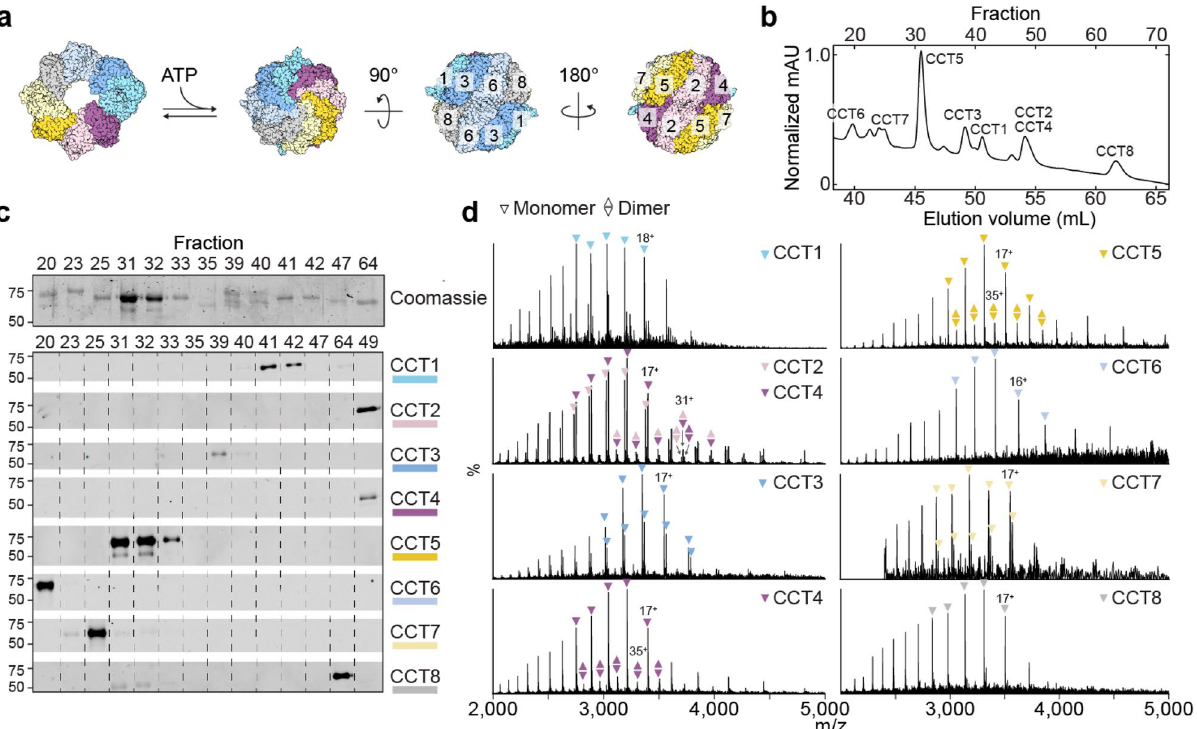
Figure 1. hTRiC subunits can be chromatographically separated for downstream intact analysis. ( a ) Top and side views of the TRiC hexadecamer, showing subunit arrangement within the two antiparallel rings. Cycles of ATP hydrolysis catalyse ring opening and closure. ( b ) Reverse phase chromatogram of recombinant hTRiC, with peaks labelled by the predominant eluting subunit(s), as determined by Western blots shown in ( c ). ( d ) Intact, denatured mass spectra of reverse phase fractions containing each hTRiC subunit. For each assigned subunit mass, five peaks are annotated with triangles and one peak with its charge state. Fractions containing CCT5, CCT2, or CCT4 contain minor populations of masses corresponding to dimers, designated by two triangles annotated over five odd charge states. (Even charge states are not labelled with the double triangle notation for simplicity, but can be inferred to overlap with monomer peaks.) In the CCT2/CCT4 spectrum, CCT2 and CCT4 homodimers were detected as well as CCT2-CCT4